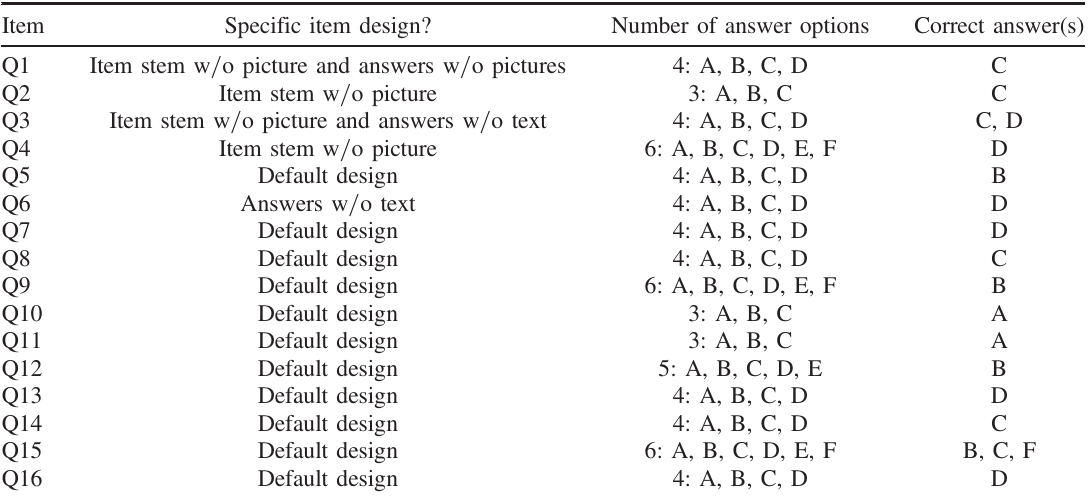
Table IX gives a detailed overview of the format of all ROC-CI items. The items ’ designs with text and picture are specified, as well as the number of answer options per item. Additionally, the correct answers of each item are listed, thereby indicating the number of correct answers for each